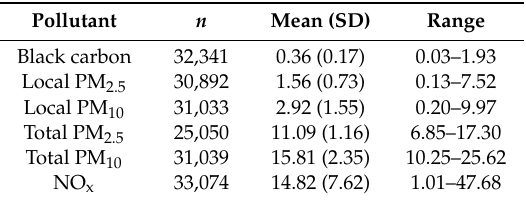
Table 2. Summary of modeled black carbon, local PM 2.5 and PM 10 , total PM 2.5 and PM 10 , and NO x exposure levels ( µ g / m 3 ) during the entire pregnancy exposure window, over the 2000–2009 period.